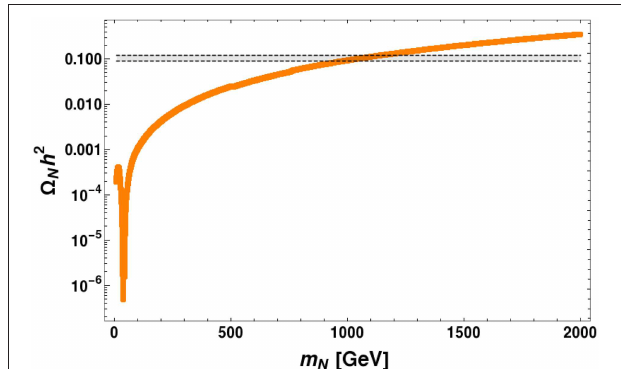
FIGURE 5 | Variation of relic density of DM N 0 with mass m N . The gray patch corresponds to relic density allowed limit from PLANCK: (cid:127) h 2 0.1166 ≤ ≤